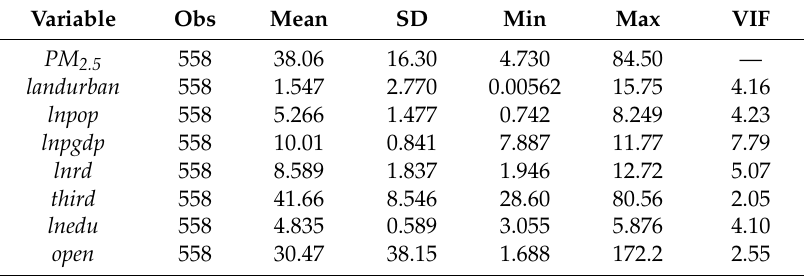
Table 2. Descriptive statistics and multicollinearity